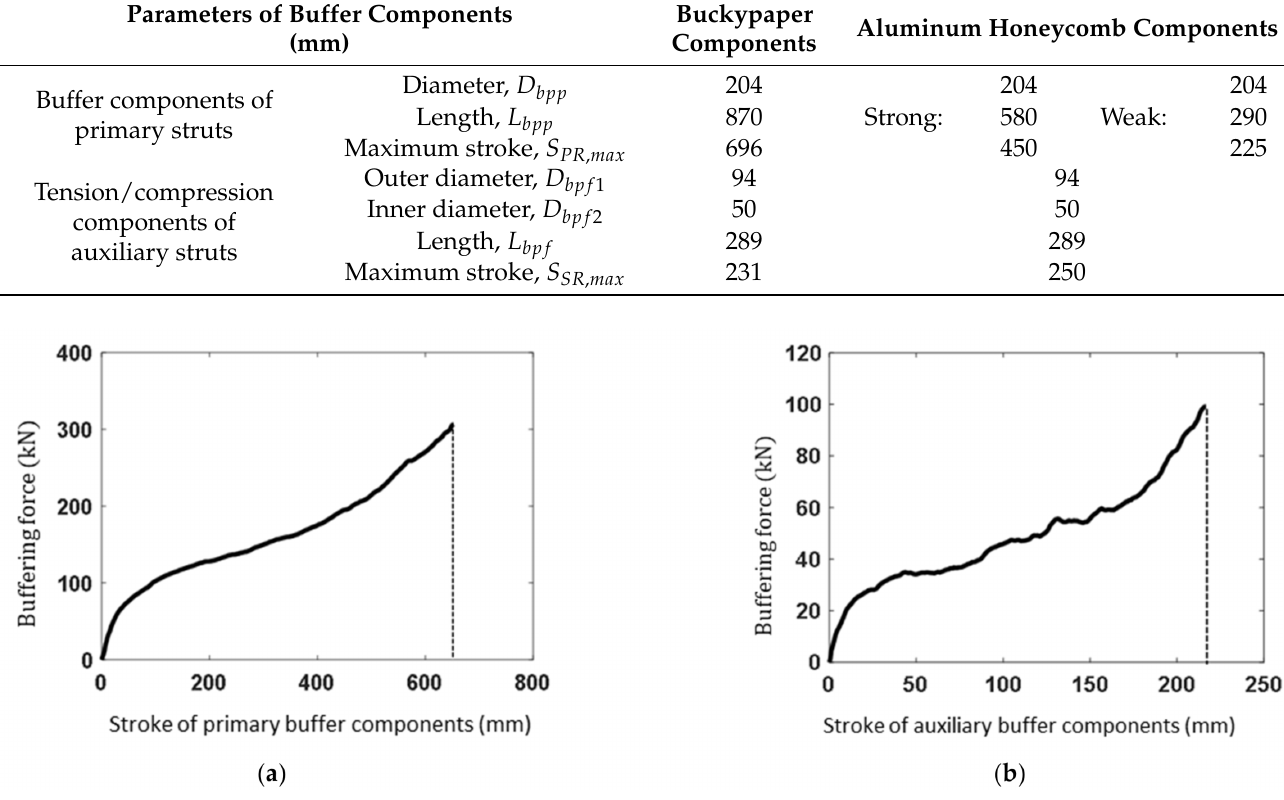
Figure 6. Buffering characteristics of buckypaper components within ( a ) primary and ( b ) auxiliary